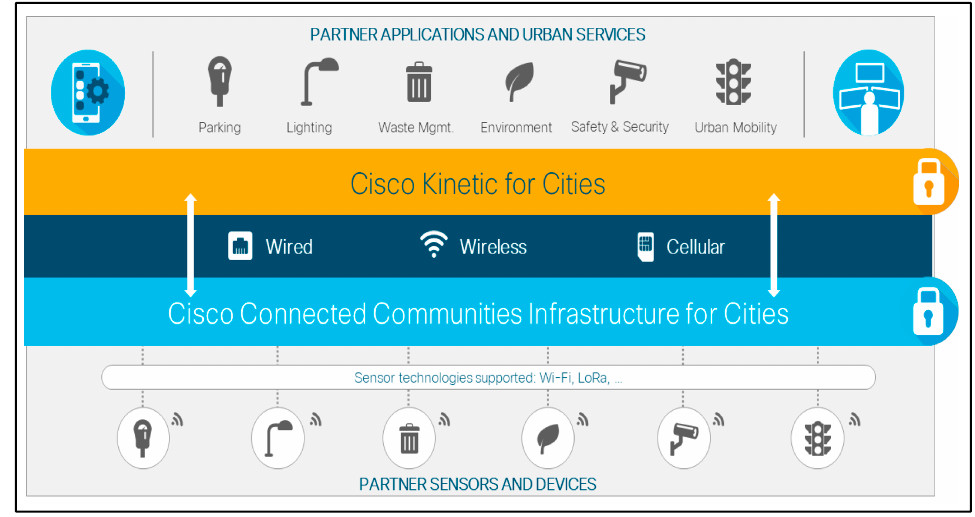
Figure 4. The Cisco Smart + Connected Digital Platform, derived from [143].